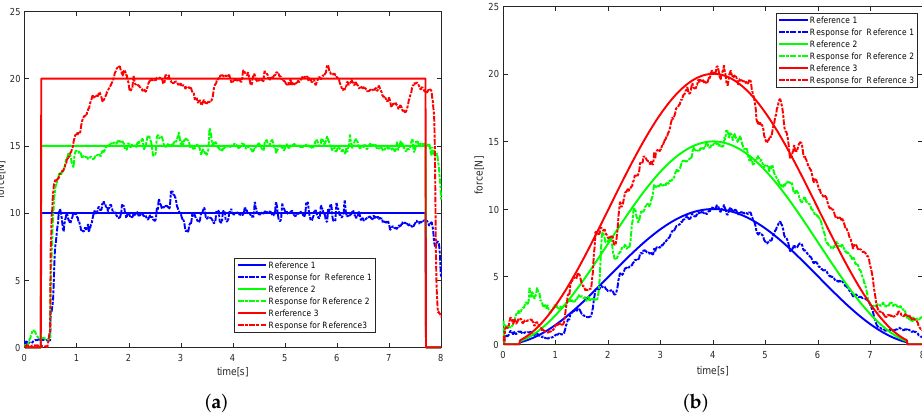
Figure 11. Experiments carried on one participant. ( a ) Step response experiments of Hybrid ADRC. ( b ) Sinusoidal response experiments of Hybrid